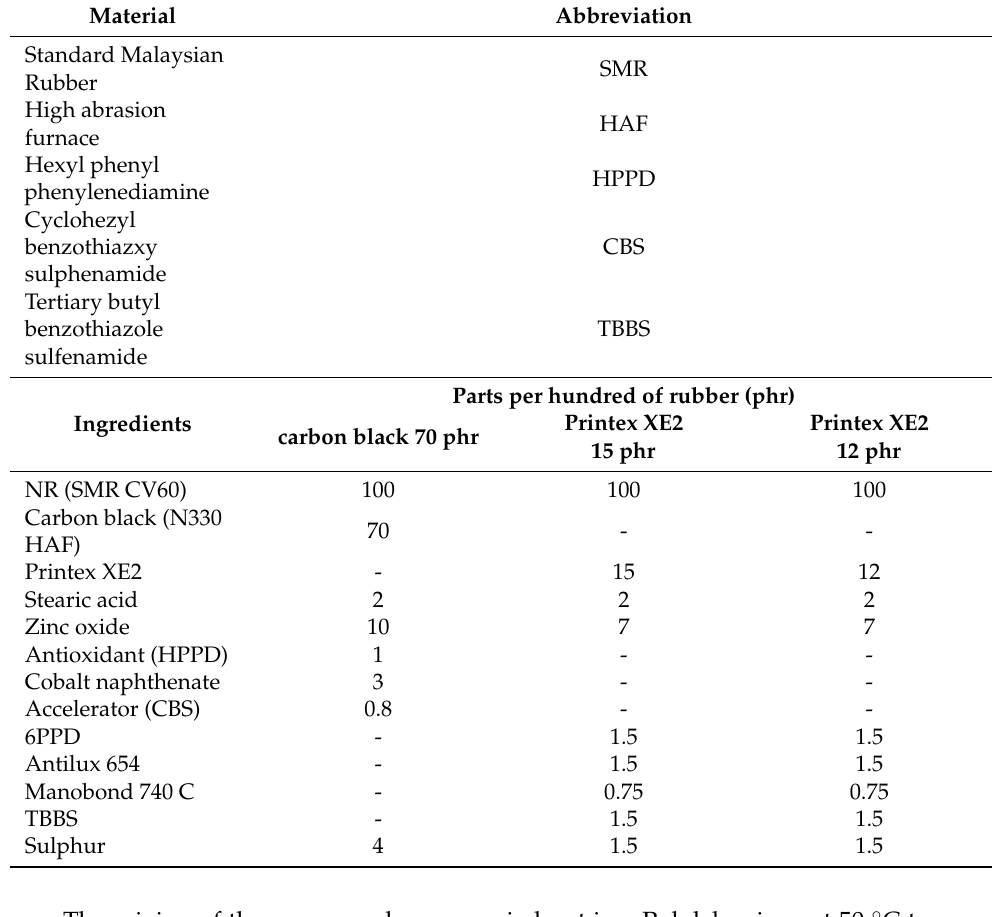
Table 1. Formulation of the filled rubber compound in weight (parts per hundred